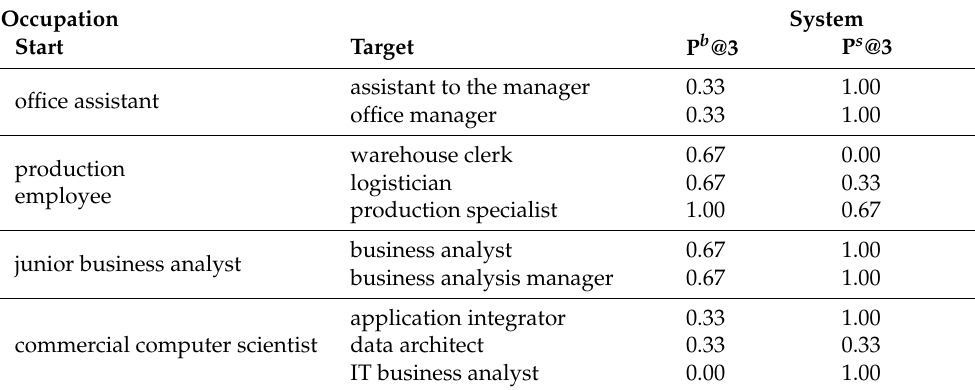
Table 8. Evaluation of the continuing education